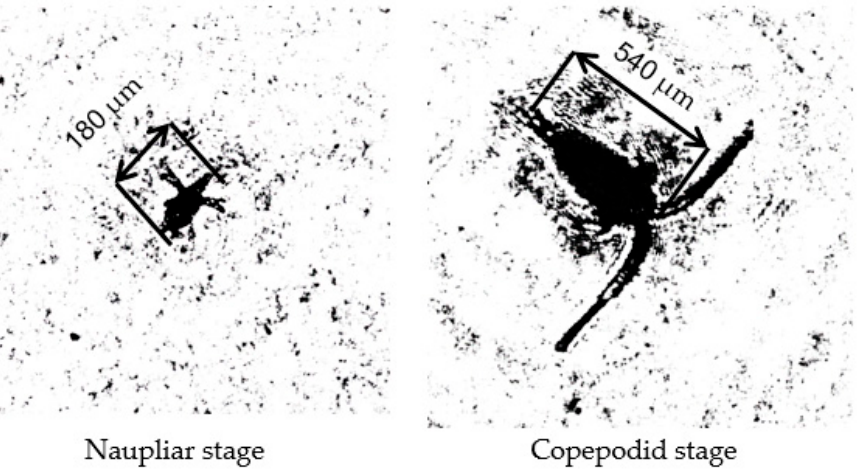
Figure 6. Holographic images of Baikal epischura of different ages obtained using in situ DHC technology during testing in Lake Baikal.